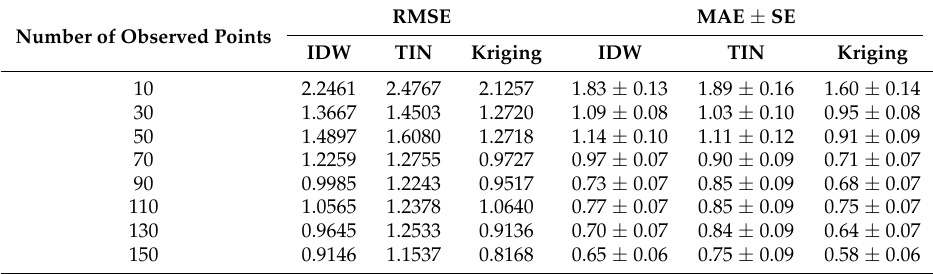
Table 4. Statistical error (RMSE and MAE with its corresponding SE) for each method. In this graph, we only show one ‘IDW’, because the errors of both versions of IDW (basic and improved, based on Table 3) are the same; the only difference between the two being the processing time.